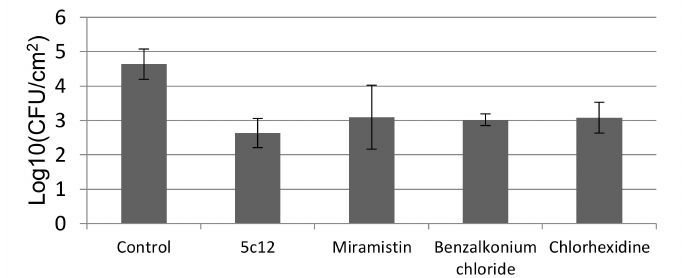
Figure 4. In vivo antibacterial e ffi cacy test (Mean ± SD) using a rat skin model. log10 number of viable cells in the control and the number of viable cells after exposure with 5c 12 , miramistin, benzalkonium chloride, and chlorhexidine, n = 6.